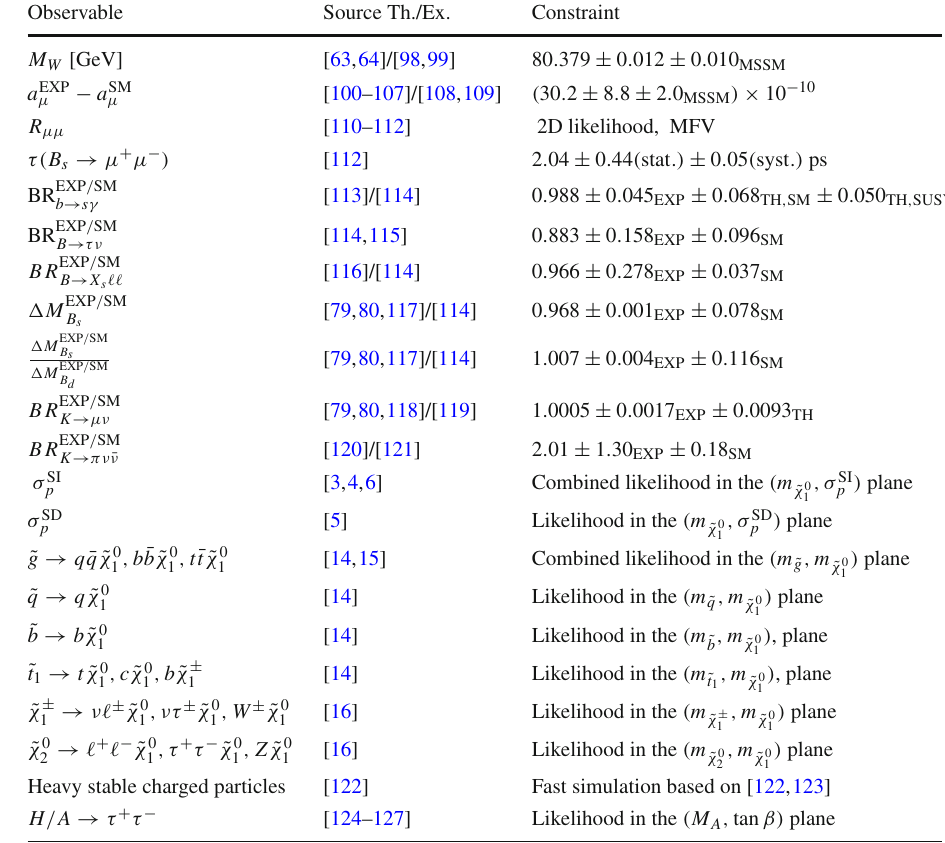
constraints that we update in this work compared to Table 1 in [34]. We indicate separately the experimental and applicable theoretical errors in the SM and SUSY (sometimes in combination, labelled “MSSM”). The contribution of the τ( B s → μ + μ − ) constraint function is essentially constant across the relevant region of the pMSSM11 parameter space, and it is not included in the fit. The new LHC constraints are all based on ∼ 36/fb of data